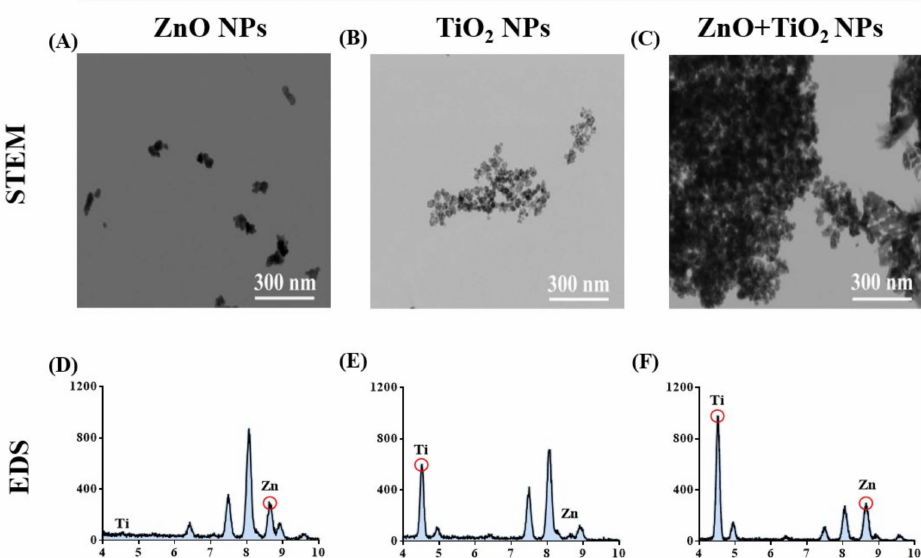
Figure 5. TiO 2 NPs increased the particle aggregation, which decreased the cellular uptake of ZnO NPs. ( A – C ) The agglomeration state of ZnO NPs ( A ), TiO 2 NPs ( B ), and their mixtures ( C ) was observed by scanning transmission electron microscopy (STEM). ( D – F ) The elemental composition present in each STEM image of ZnO NPs ( D ), TiO 2 NPs ( E ), and their mixtures ( F ) was identified by energy-dispersive X-ray spectroscopy (EDS). Table 2. The hydrodynamic size of ZnO, TiO 2 NPs, and their mixtures in DMEM high sugar medium with 10% FBS.